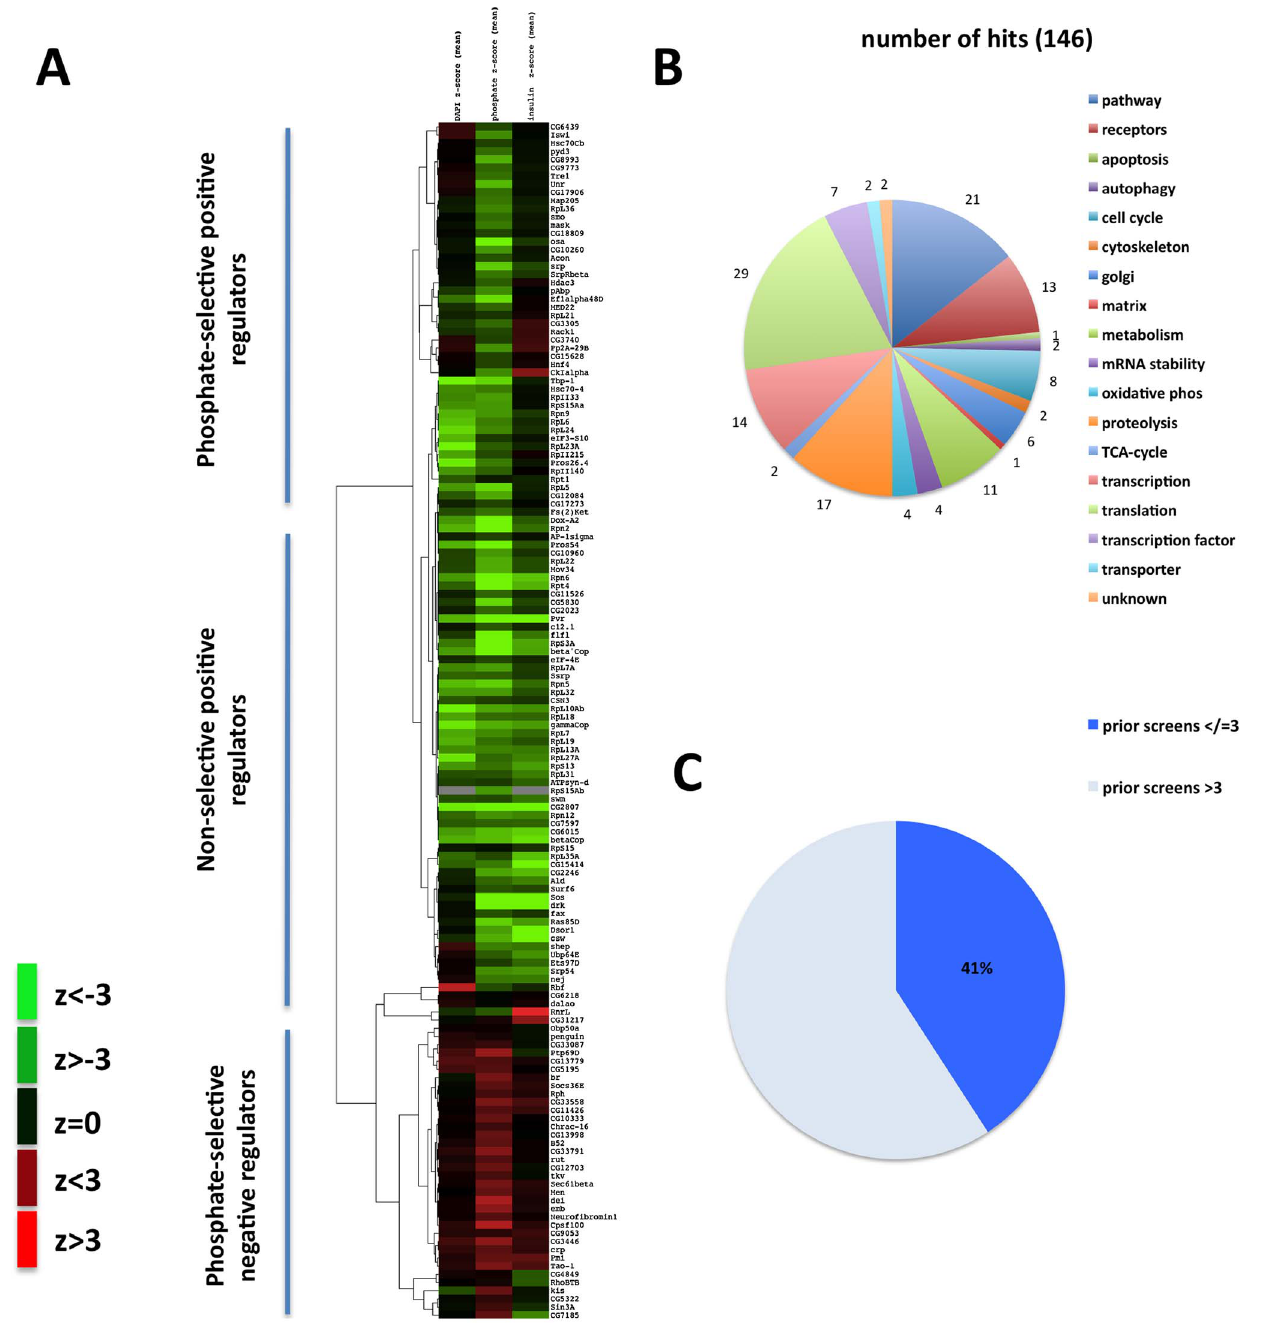
Figure 6. S2R + genome-wide RNAi screen. A: heatmap of z-scores for 146 verified genes, cell count/well based on DAPI signal (first column), dpERK signal after 10 min. phosphate stimulation (middle column), and dpERK signal after 10 min. insulin stimulation (third column), green indicates positive regulators, red indicates negative regulators. B: Functional classification of 146 verified genes based on GO term categories using the DAVID tool (http://david.abcc.ncifcrf.gov/) [27], and FlyMine (www.flymine.org/) [28]. C: Number of genes identified in prior DRSC screens.